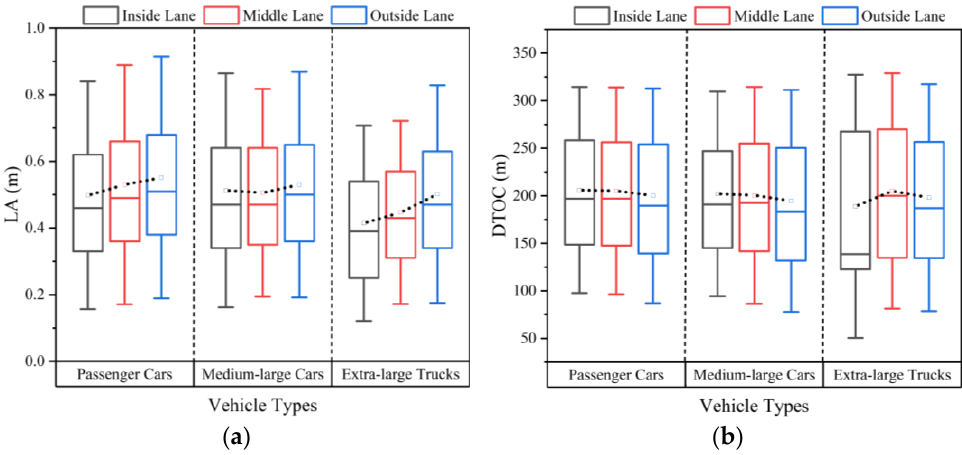
Figure 10. ( a ) Distribution of the LA in different lane positions; ( b ) Distribution of the DTOC in different lane positions.